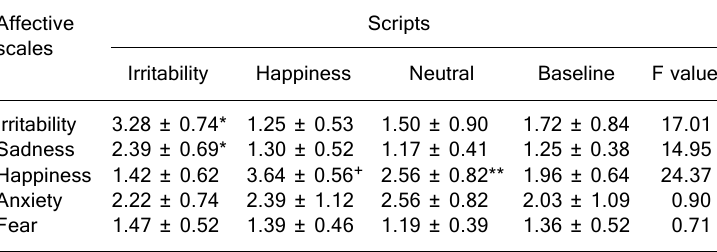
Table 1. Subjective self-report ratings of emotions during each personal script presentation and the baseline condition (N =